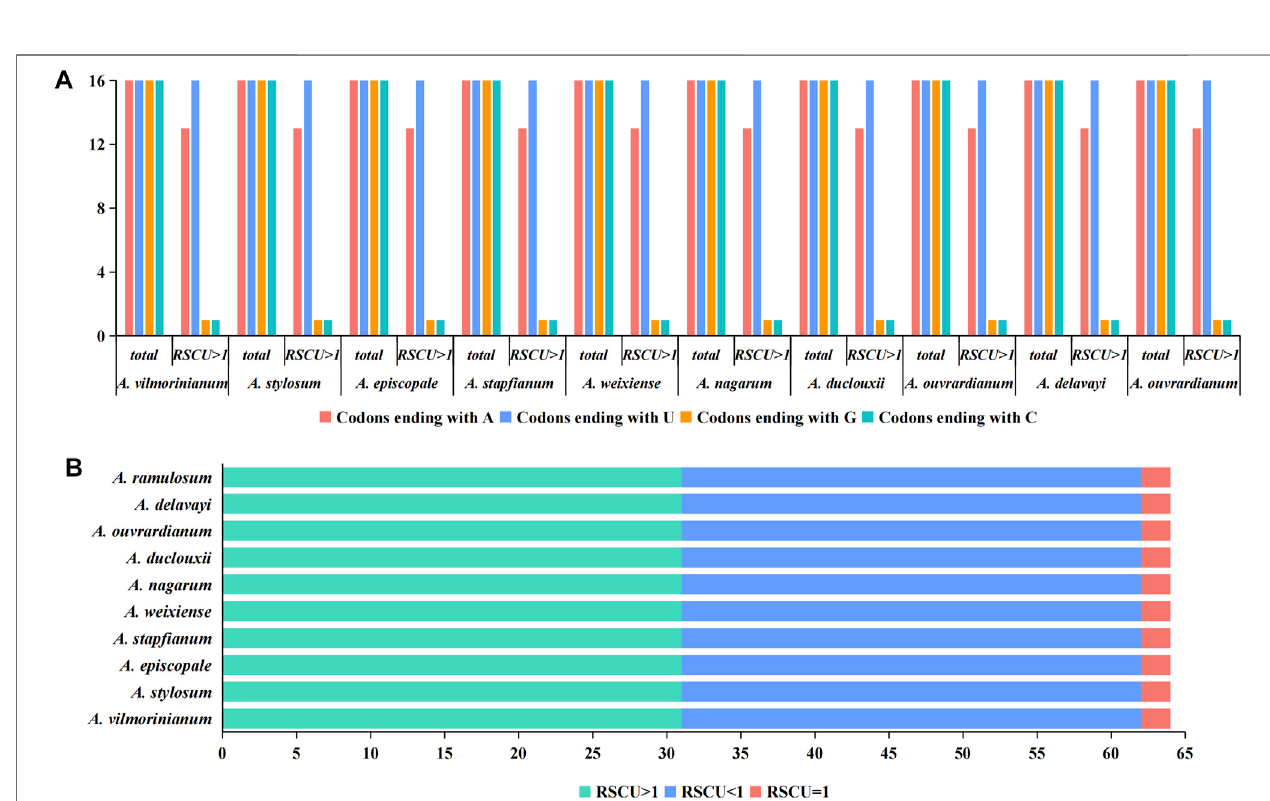
FIGURE4| Analysisofcodonbiasinthechloroplastgenomeoften Aconitum species. (A) Analysisofterminalbasesatcodonsinchloroplast genomes; (B) RSCU value analysis of codons in chloroplast genomes.